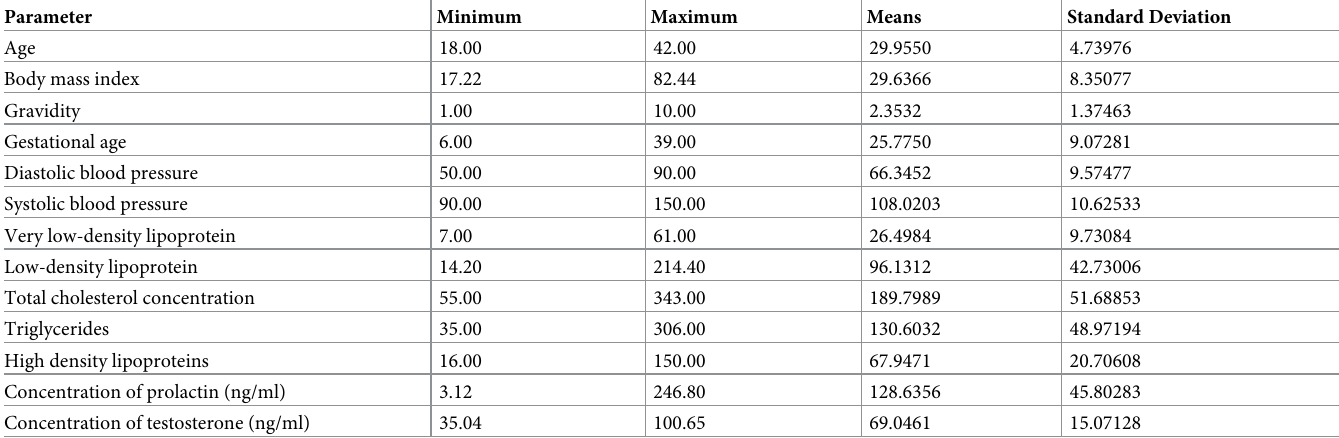
Table 1. Descriptive characteristics of participants in the study.